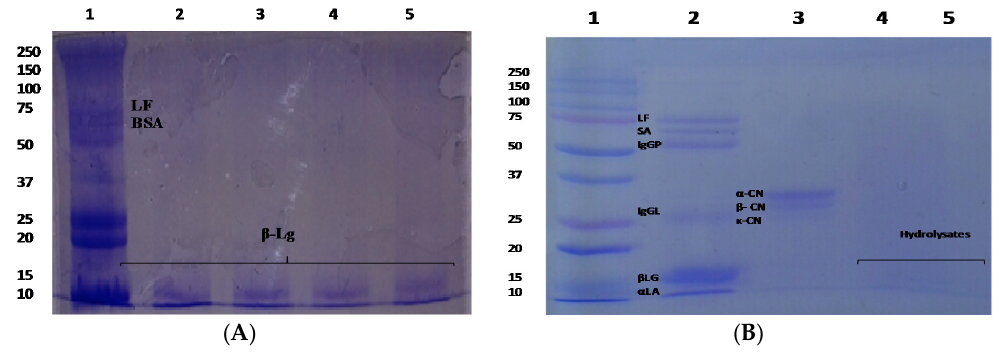
Figure 2. SDS-PAGE electrophoresis analysis of milk proteins with 2-mercaptoethanol. ( A ) Whey proteins. Lane 1: whole milk; lane 2: milk 1; lane 3: milk 2; lane 4: milk 3; lane 5: milk 4. ( B ) Hydrolysates. Lane 1: Standard protein; lane 2: whey protein; lane 3: casein proteins; lane 4: whey protein hydrolysate; and, lane 5: casein hydrolysate.